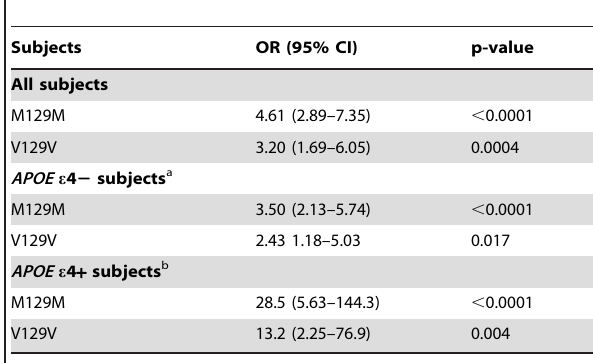
Table 5. Odds ratios for the association between CJD and PRNP codon 129 in different strata defined by APOE e 4 allele status (M129V genotype is taken as reference or non-